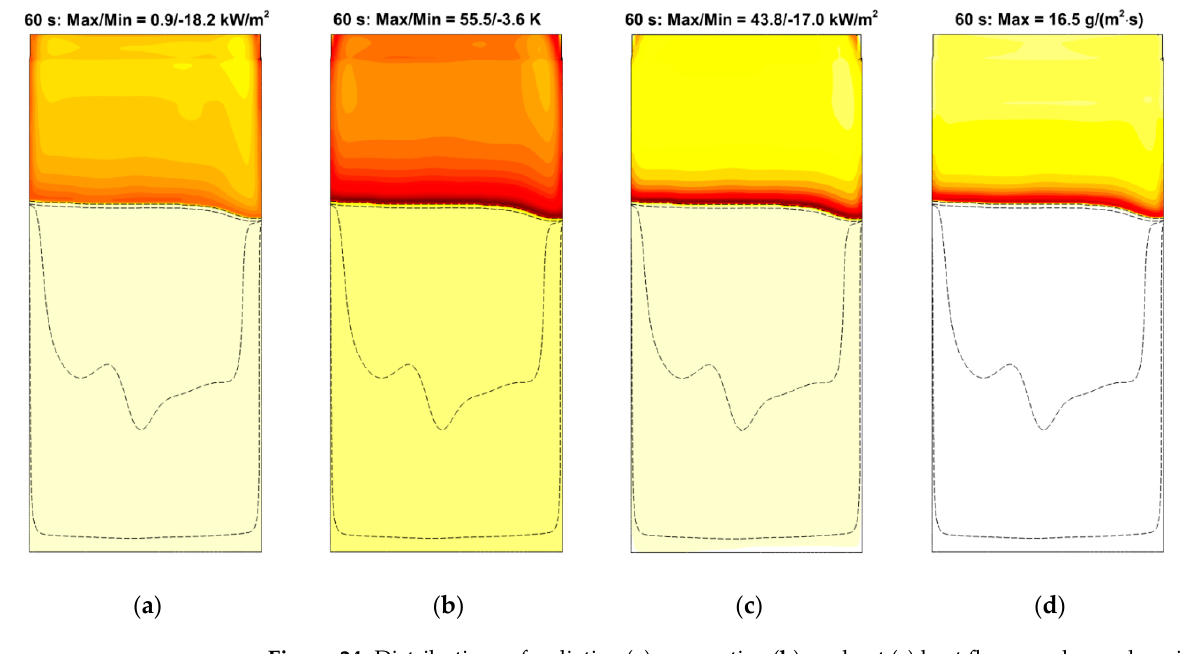
25 of 31 Figure 23. Visualization of downward flame spread at time instants in multiples of 30 s by variation of the layer thickness. The specimen surface is colored by the net heat flux received by the layer. Spatial distributions of radiative, convective, and net heat fluxes, as well as of the mass burning rate over the specimen surface at a particular time instant are demonstrated in Figure 24, which shows the formation of the sharp pyrolysis front that separates the virgin material and the burning area. Distributions of the temperature, incident radiation, heat fluxes, and mass burning rate at the specimen surface along the